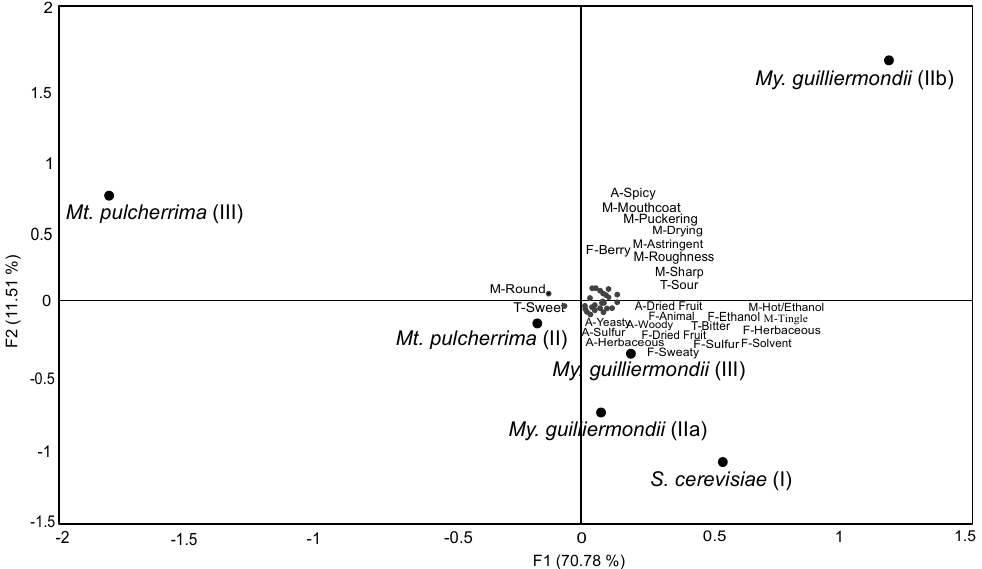
Figure 5. Principal component analysis of sensory attributes found to be significantly different ( p < 0.05) by trained panel ( n = 10) between wines produced with S. cerevisiae alone (fermentation temperature regime I) or with sequential inoculation of Mt. pulcherrima or My. guilliermondii followed by S. cerevisiae (fermentation temperature regimes II or III). Table 3. Mean scores for sensory attributes of wines inoculated without or with different non -Sac- charomyces yeasts following fermentation temperature regimes I, II, or III . Treatment